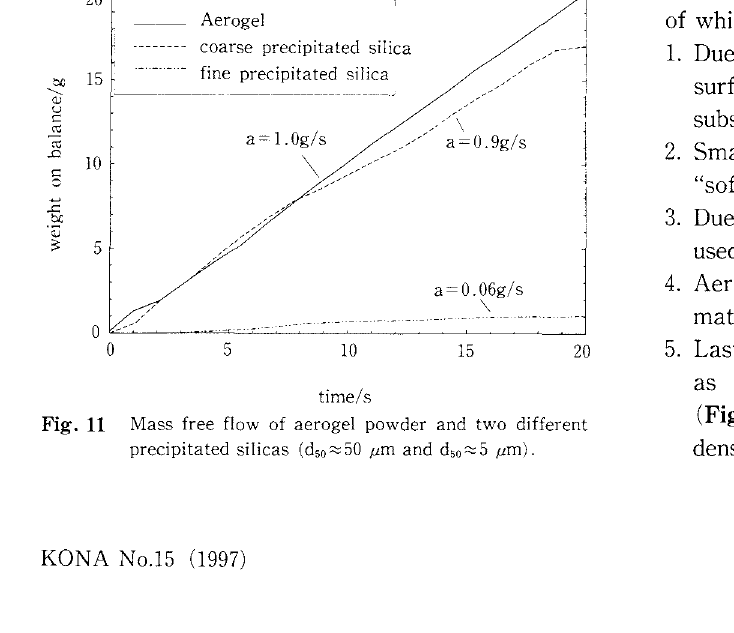
Fig. 11 Mass free flow of aerogel powder and two different precipitated silicas (d 50 "'50 J.lm and d 50 "'5